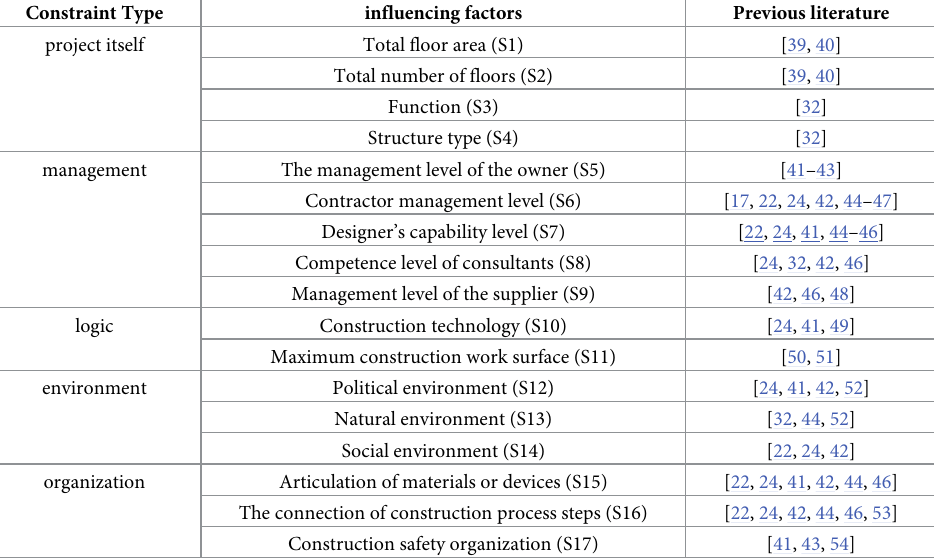
Table 3. Influencing factors of the minimum construction period under sufficient resources.